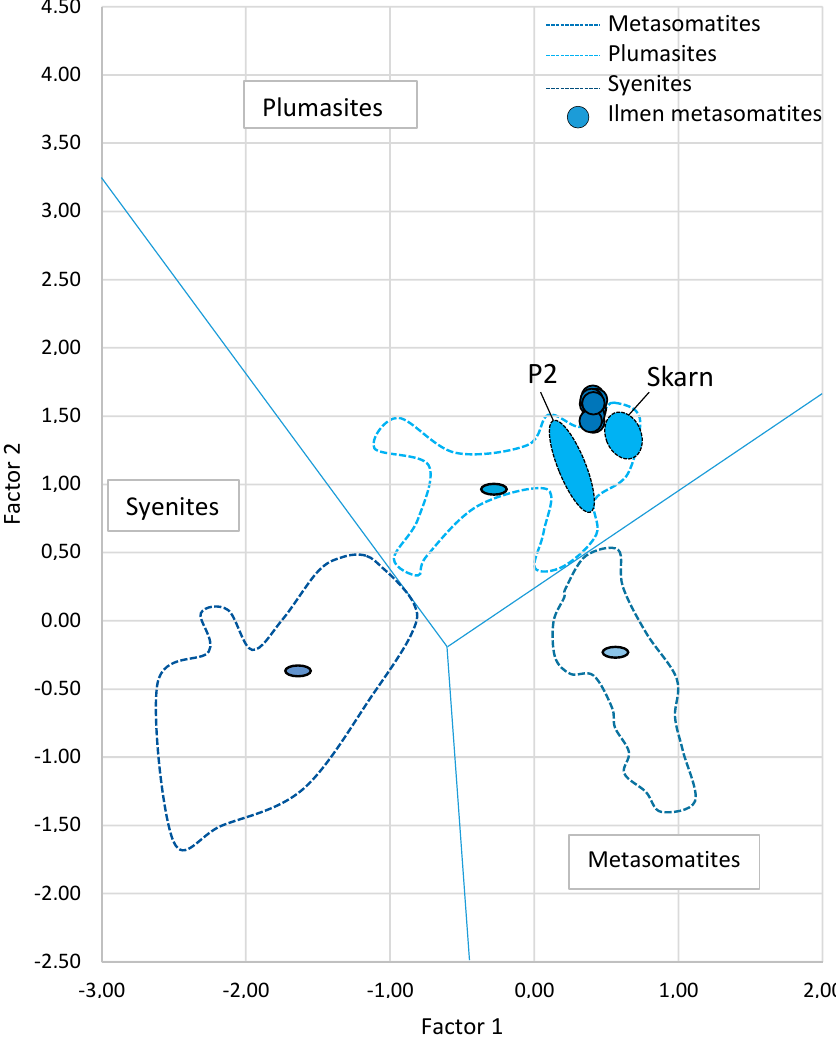
Figure 9. A plot of Ilmen sapphires within meta-ultramafic rocks (bold blue circles) in discriminant factors diagram is modified after [18]. Colored ovals are averages of syenites, plumasites, and metasomatites. P2 is an extension of metasomatic type according to [18].